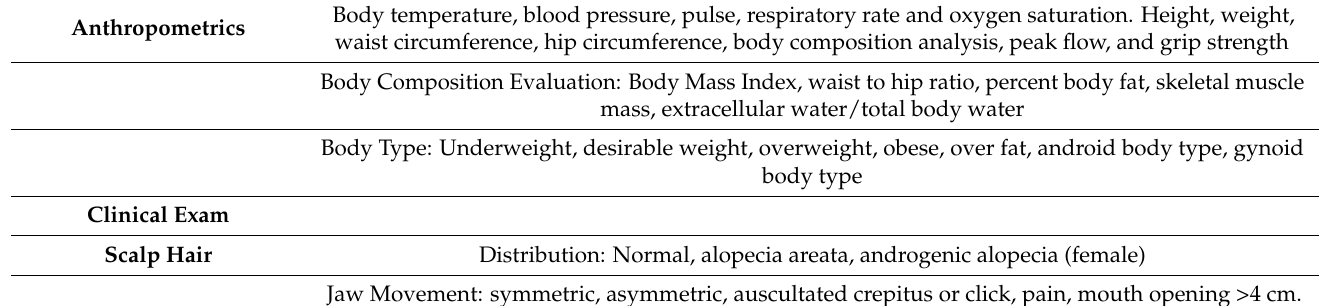
Table 1. Components of the FiNE; Anthropometric and Clinical Exam.